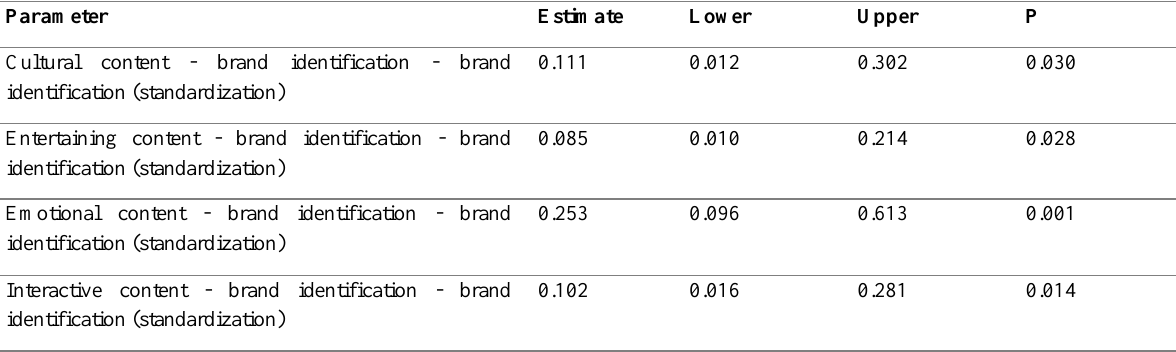
Table 7: Test of mediating effect in brand identification for “New Guochao” brands